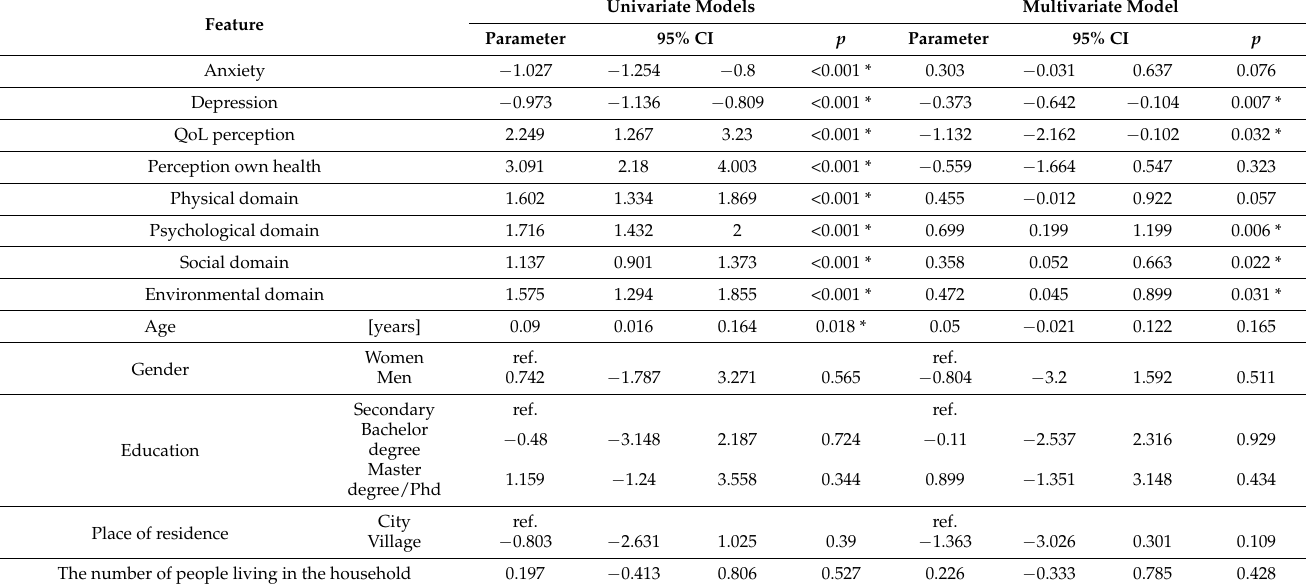
Table 6. Job satisfaction–mono- and multifactorial regression